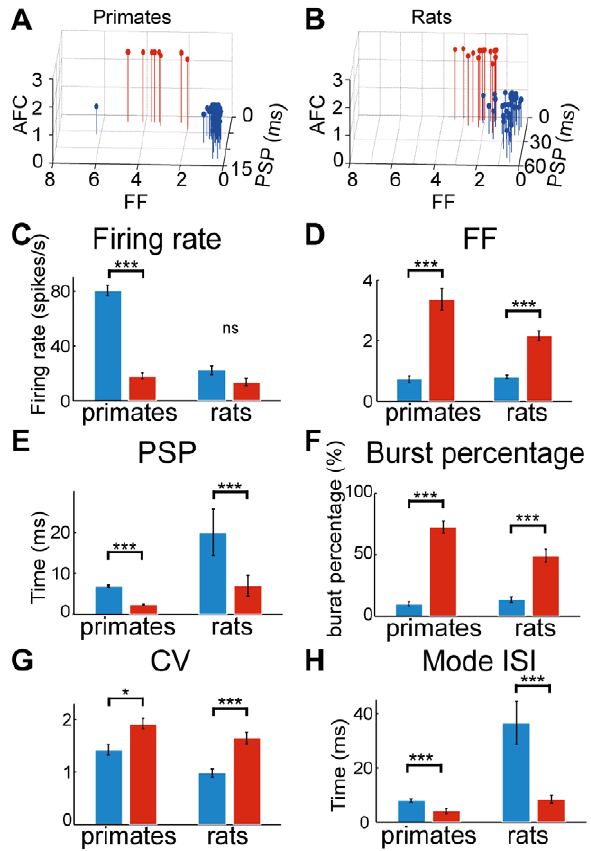
Figure 3. Neuronal classification and firing properties in primates and rats. A and B: 3 dimensional presentation of firing properties leading to the formation of distinct clusters in primates (A) and rats (B). C–H: Bar plots representing parameters of the two groups (HFP - blue, LFB - red) in the two species (left two bars - primates, right two bars - rats). doi:10.1371/journal.pone.0045421.g003 parameter (LFB: 244.2 6 22.0 m s; HFP: 350.0 6 21.5 m s; p , 0.01; Mann-Whitney U-test; Fig. 4D).